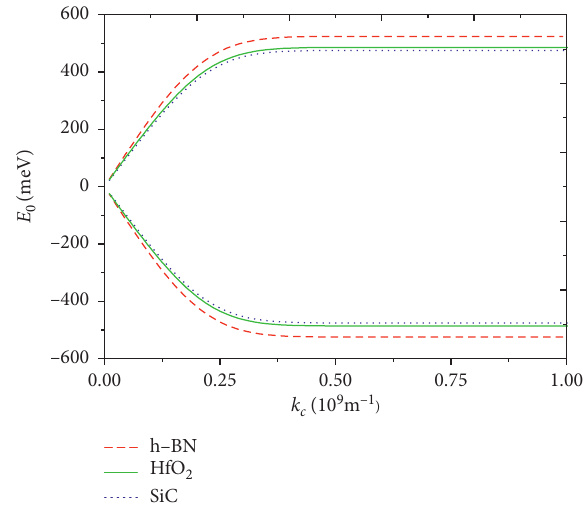
Figure 3: Variable cutoff wavenumber k E . 0